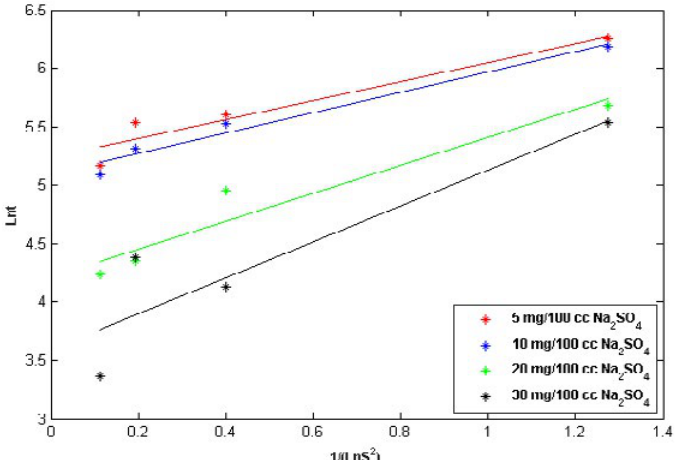
SO concentrations based on primary nucleation theory 2 4